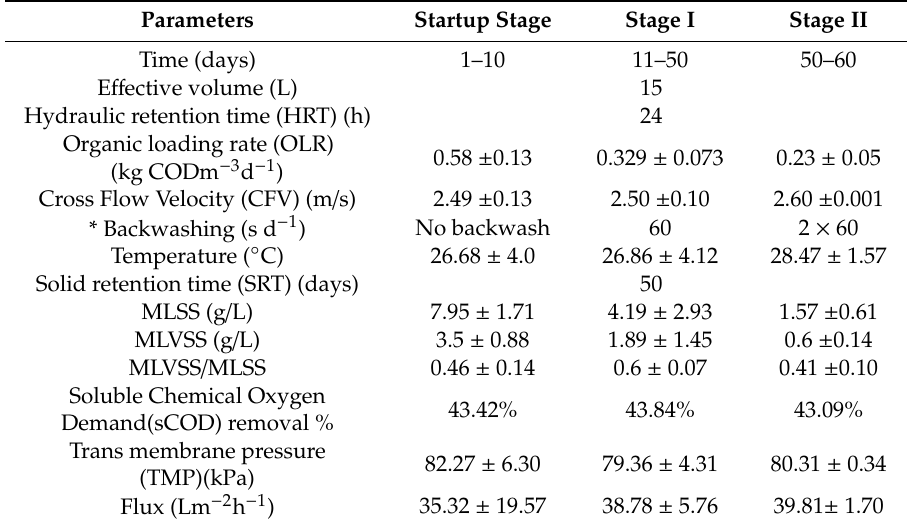
Table 1. Operational parameters in the AnCMBR of this